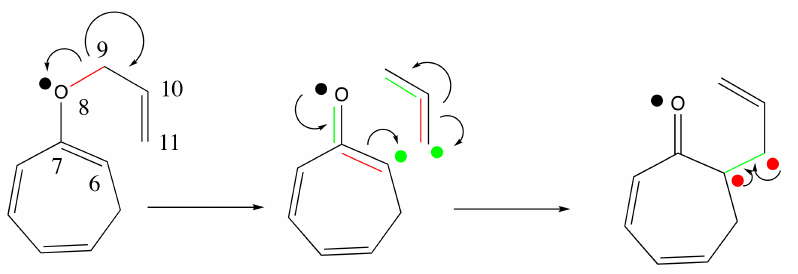
Scheme 2. Curly arrow representations of the main electron density flows of the reaction from 1 to 2 .